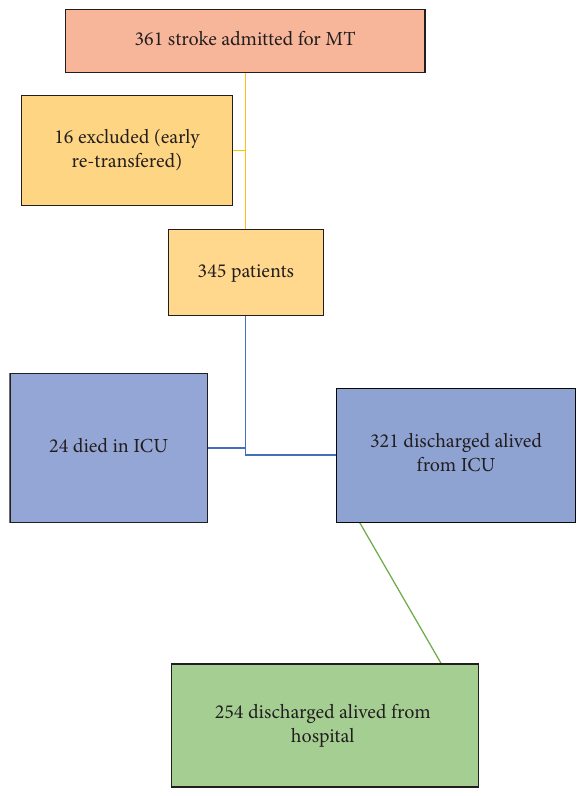
Figure 1: Patients